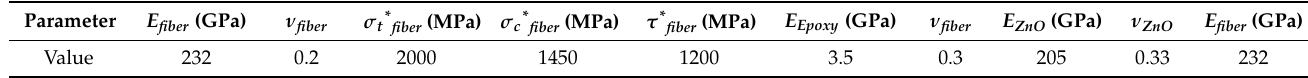
Table 1. Material properties of fiber, ZnO, and epoxy used for the